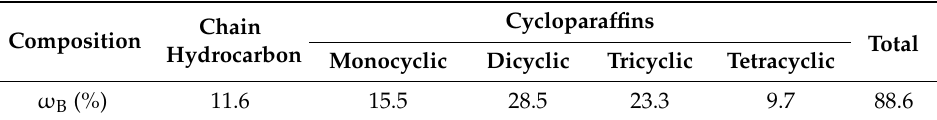
Figure 2. Molecules used during simulations of naphthenic mineral oil. Table 1. Mass-based percentages of various molecules used during simulations of naphthenic mineral oils.